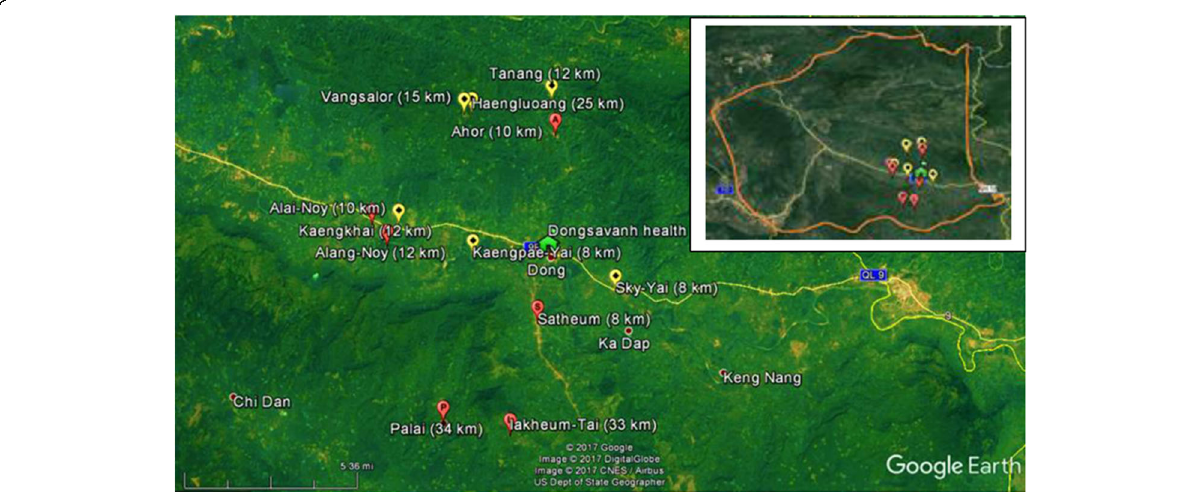
Fig. 2 Map of the study villages. The maps show the villages in which the present study was conducted. The red points indicate the locations of case villages, and the yellow points indicate the locations of control villages along with the distance of each from Xepon district hospital according to the hospital ’ s